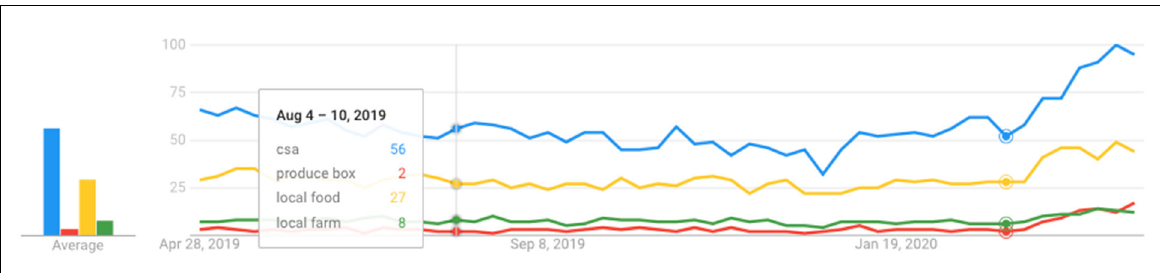
Figure 2. Interest Over Time: Switching to More Local Direct Options